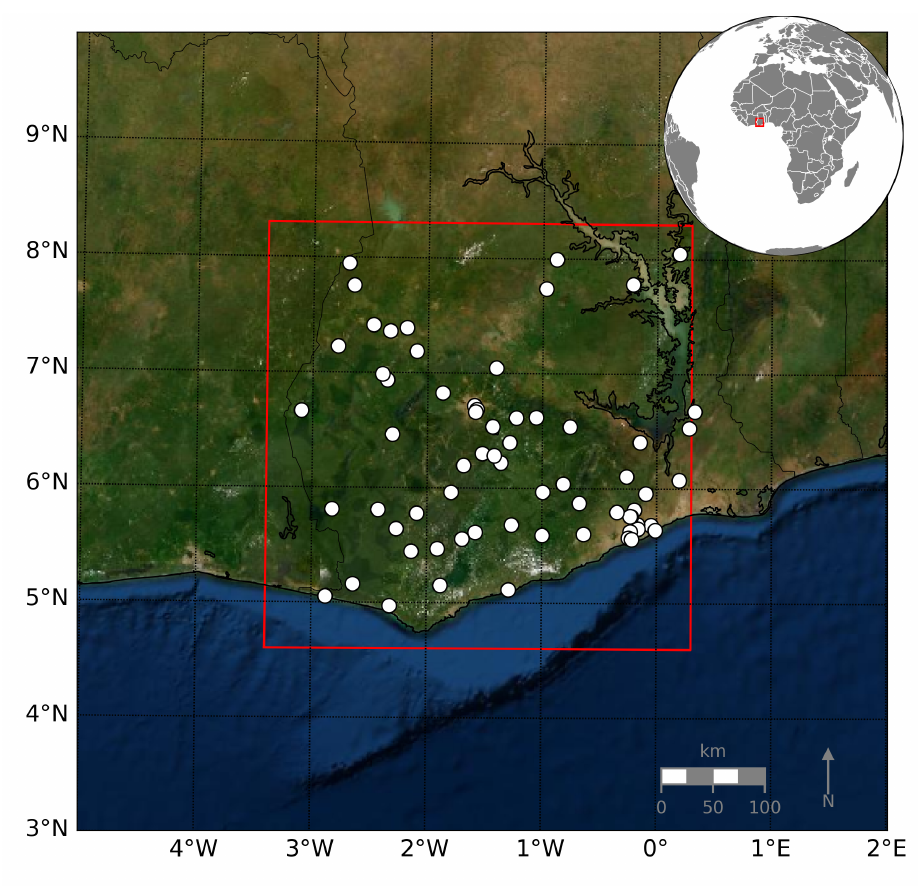
Figure 4. Study domain (red rectangle) and the TAHMO stations available within the domain (white